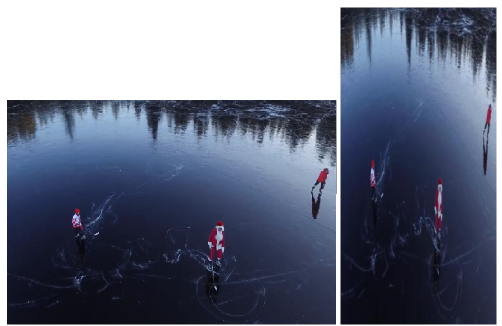
Figure 3. Actual frame and rescaled